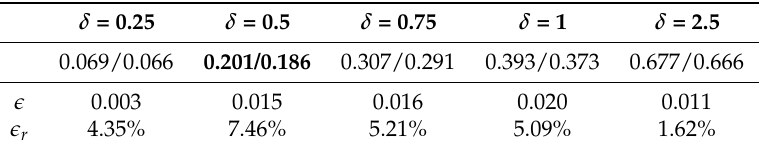
Table 1. Case study I. Traffic Saving Ratio (TSR).